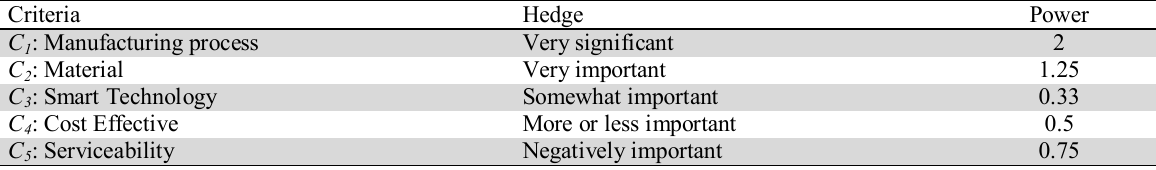
Various attributes with power of concentrator or dilators